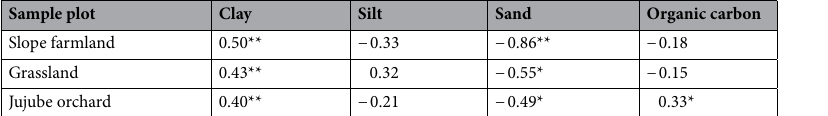
Table 3. Correlation between soil moisture content and particle composition and organic carbon in deep soil of study area. "*" in the table represents the significance level at 0.05, and "**" represents the significance level at